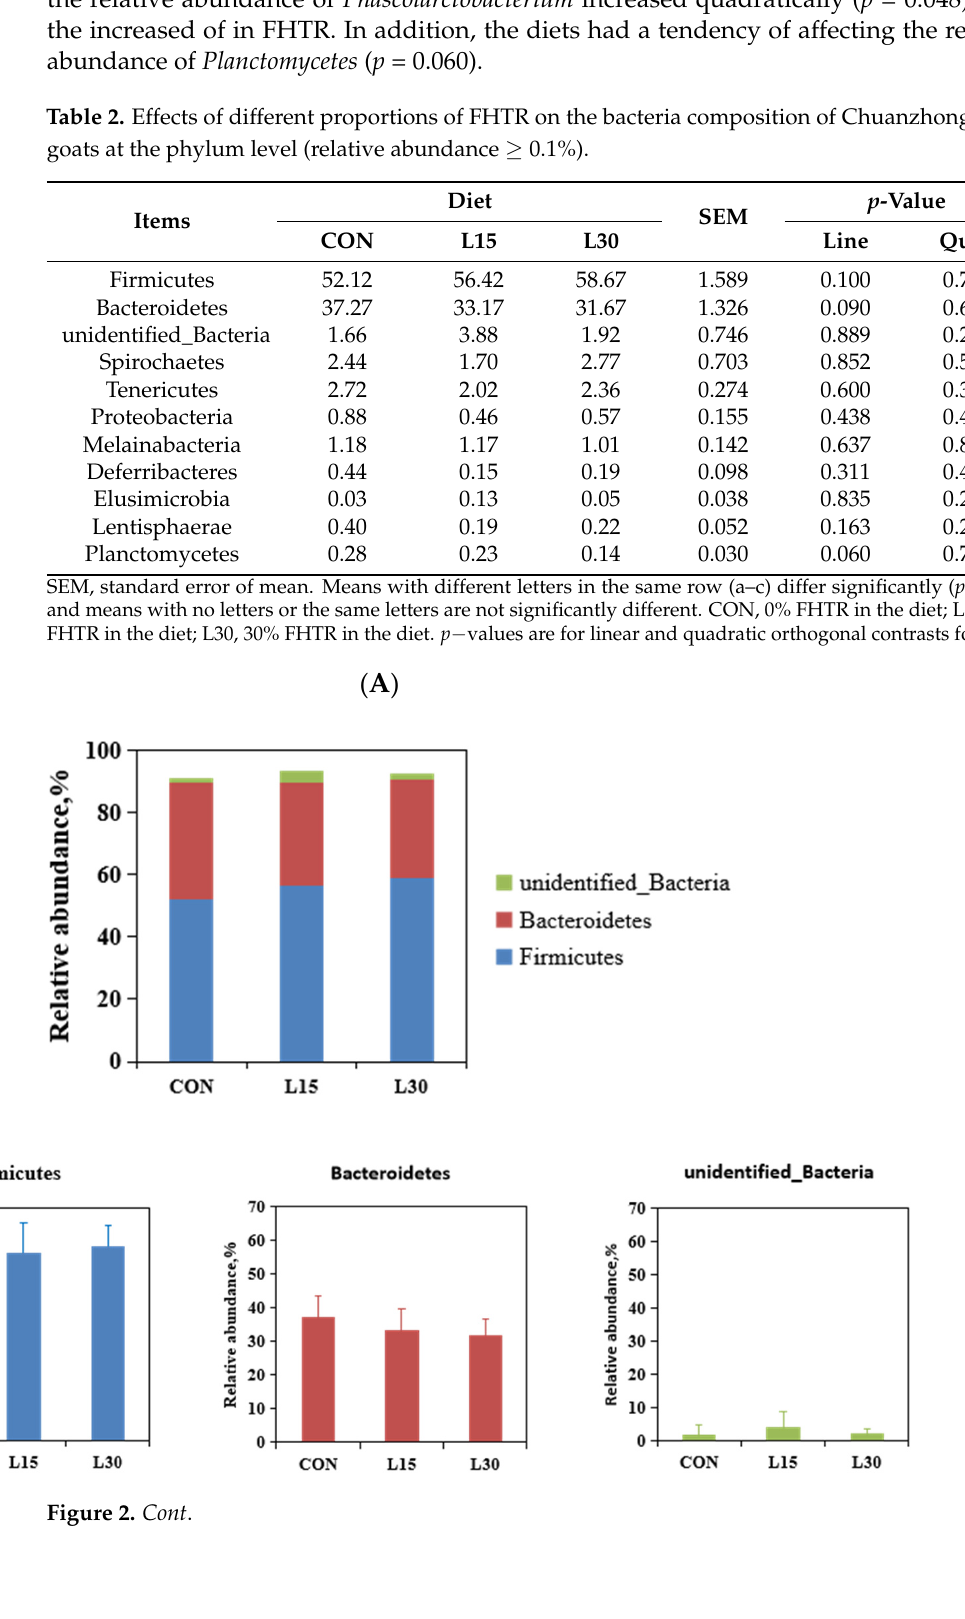
Table 3. Effects of different proportion of fermented herbal tea residue on bacterium composition at general level of Chuanzhong black goats (relative abundance ≥ 0.1%).